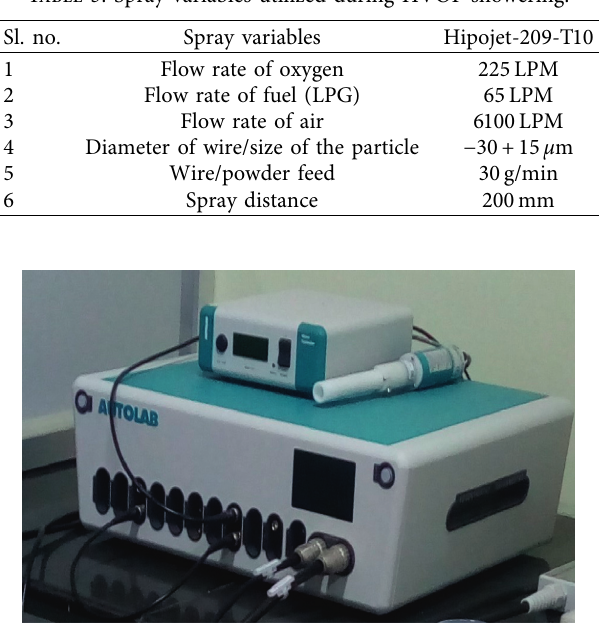
Figure 1: Electrochemical workstation to identify the utilization of potentio-dynamic polarizing bends and electrochemical imped- ance